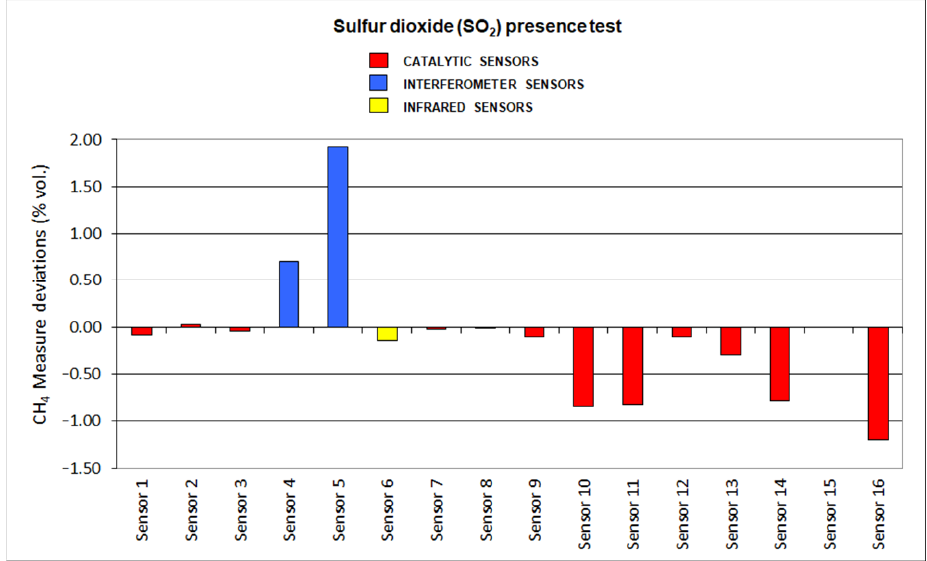
Figure 12. Sulfur dioxide presence results.